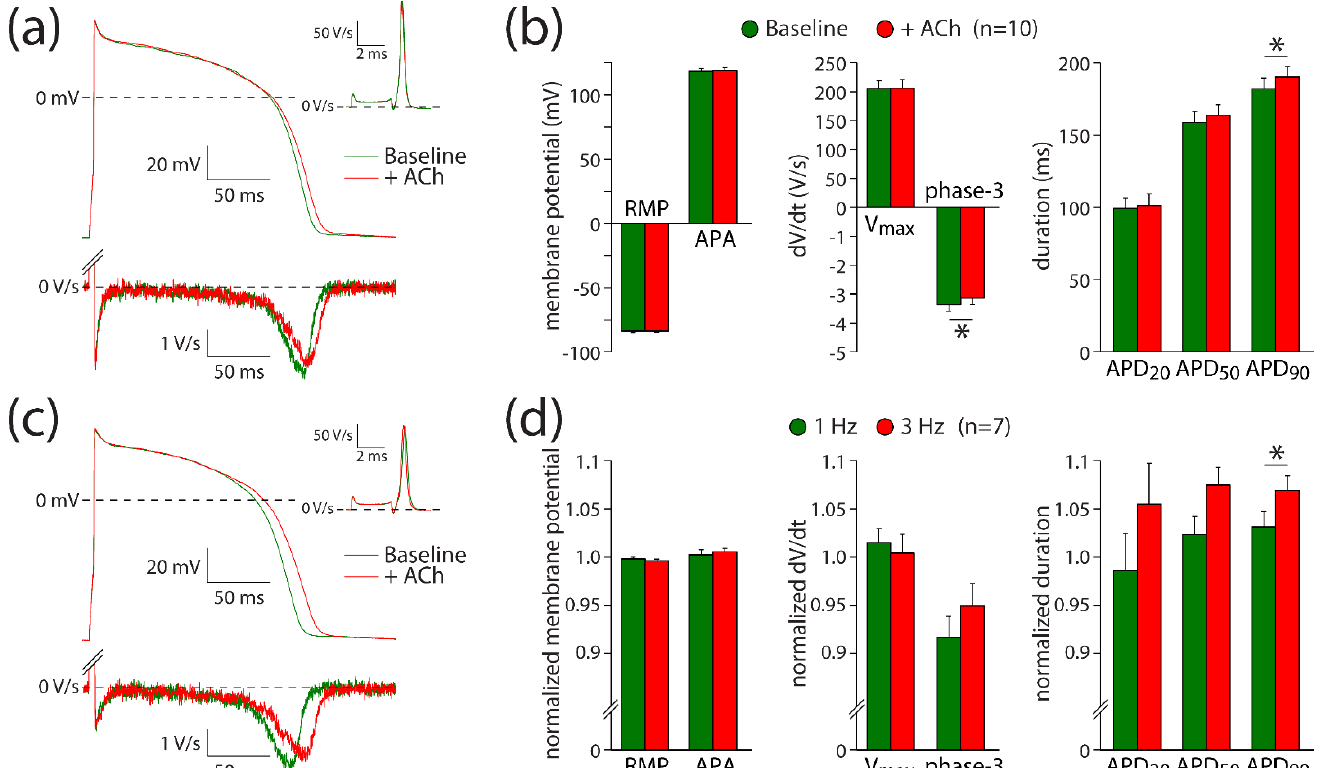
Figure 4. ACh prolongs APs in a frequency-dependent way. ( a ) Typical APs (top panel) and their first derivative of the AP upstroke (inset) and repolarization phases (bottom panel) at 1 Hz under baseline conditions and in presence of 5 µM ACh. ( b ) Average AP parameters at 1 Hz under baseline conditions and in presence of 5 µM ACh. ( c ) Typical APs (top panel) and their first derivative of the AP upstroke (inset) and repolarization phases (bottom panel) at 3 Hz under baseline conditions and in presence of 5 µM ACh. ( d ) Normalized effects of ACh on APs recorded at 1 and 3 Hz. RMP: resting membrane potential; V max : maximal AP upstroke rate; APA: AP amplitude; APD 20 , APD 50 , APD 90 : AP duration at 20, 50, and 90% repolarization, respectively; phase-3: maximal phase-3 repolarization rate. * p < 0.05.